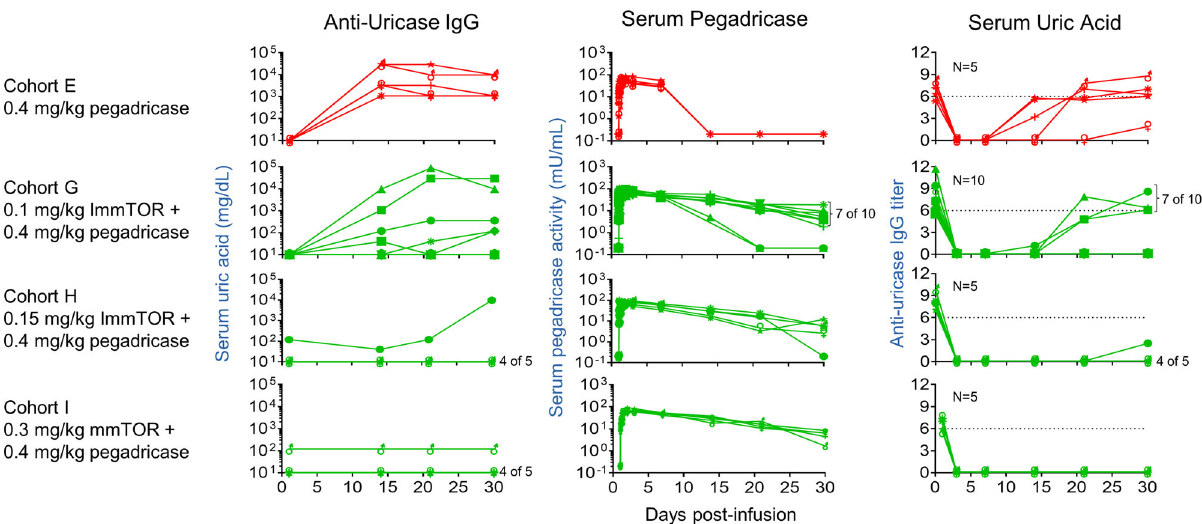
Fig. 4 Correlation of sUA with anti-uricase IgG and serum pegadricase activity. Anti-uricase IgG titers, serum pegadricase activity, and sUA are plotted against time for individual patients in cohorts A, G, H, and I. Each line represents an individual antibodies to uricase at baseline. Importantly, the patient dosed with 0.3 mg/kg ImmTOR and 0.4 mg/kg pegadricase showed no further increase in the levels of anti-uricase antibodies from baseline, although the patient dosed with 0.15 mg/kg ImmTOR and 0.4 mg/kg pegadricase developed ADAs by Day 30 (Fig. 4). In of pegadricase, some patients developed antibodies against the PEG moiety. In general, the anti-PEG antibodies were transient and occurred only in a subset of patients that developed anti- uricase IgG. Importantly, ImmTOR treatment was also effective